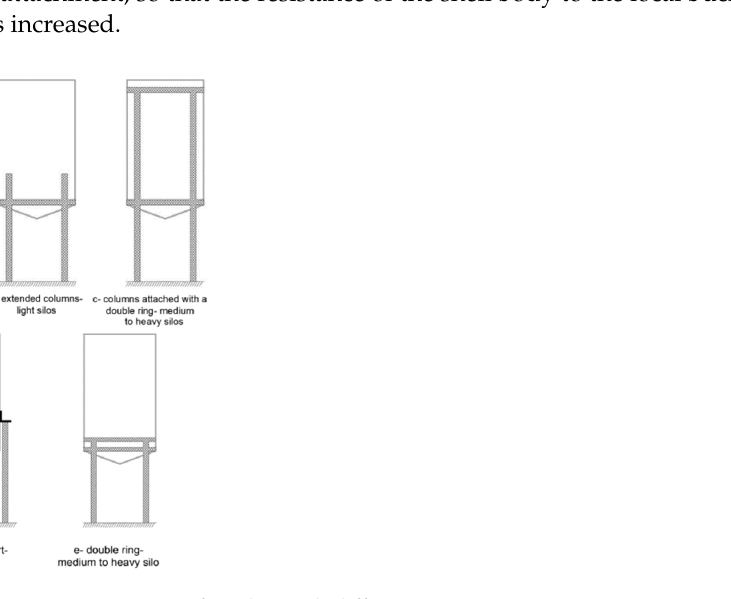
Figure 3. Alternative arrangement for silos with different supporting structures.